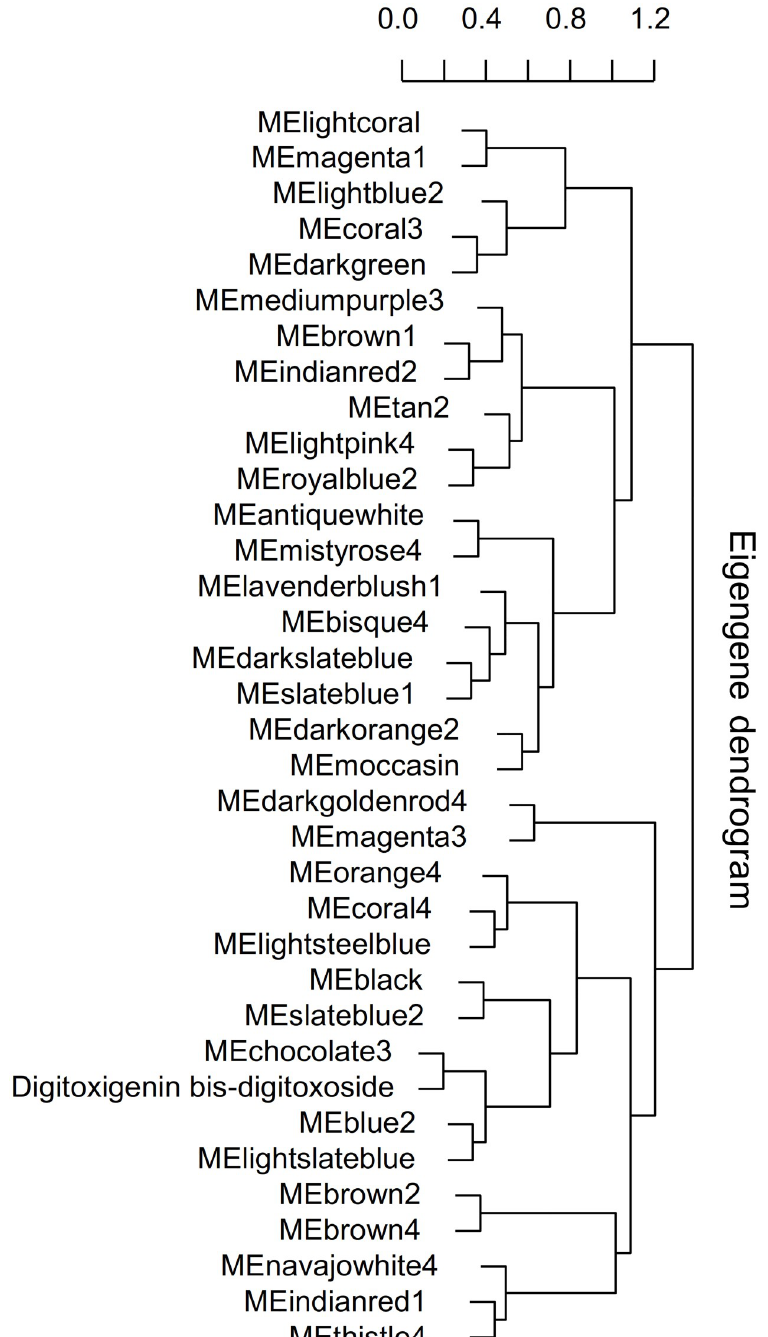
Fig 7. Eigengene dendrogram of the modules and digitoxigenin bis-digitoxoside. A hierarchical clustering dendrogram of eigengenes. The dissimilarity of E I and E J is shown by 1- cor ( E I ; E J ).